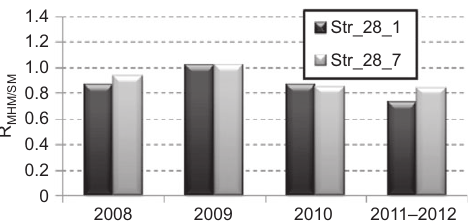
Figure 10 Ratio of residual errors of MHM and SM.